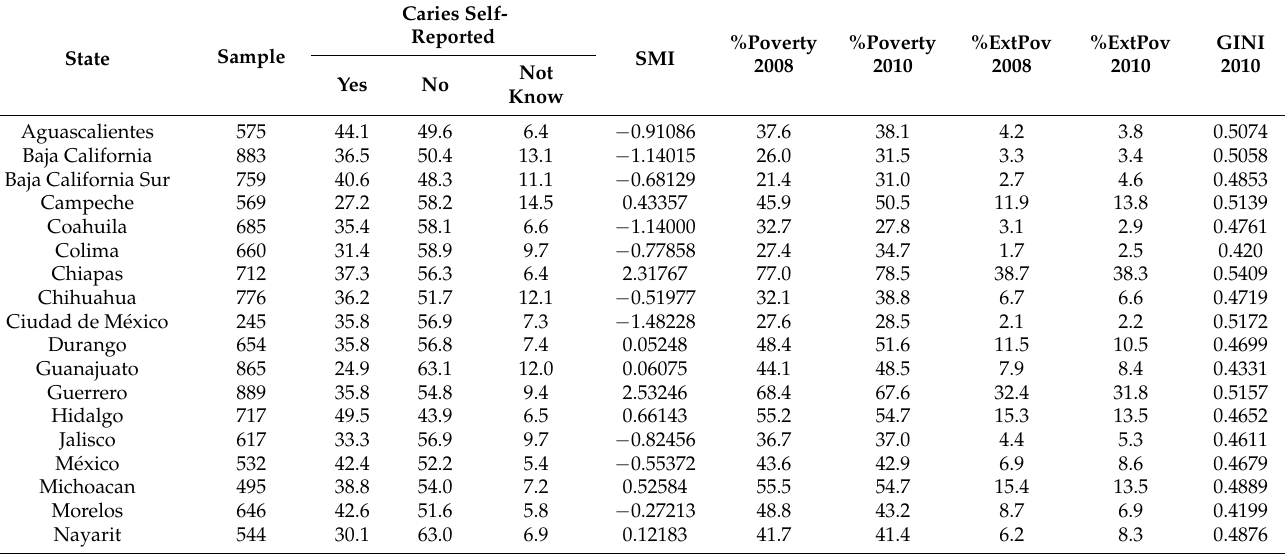
Table 2. State prevalence of caries self-reported in middle schoolchildren in